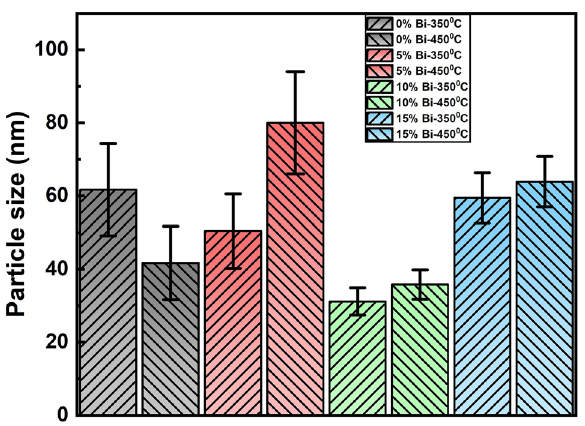
Figure 4. The histogram of the particle size distribution in the annealed films.